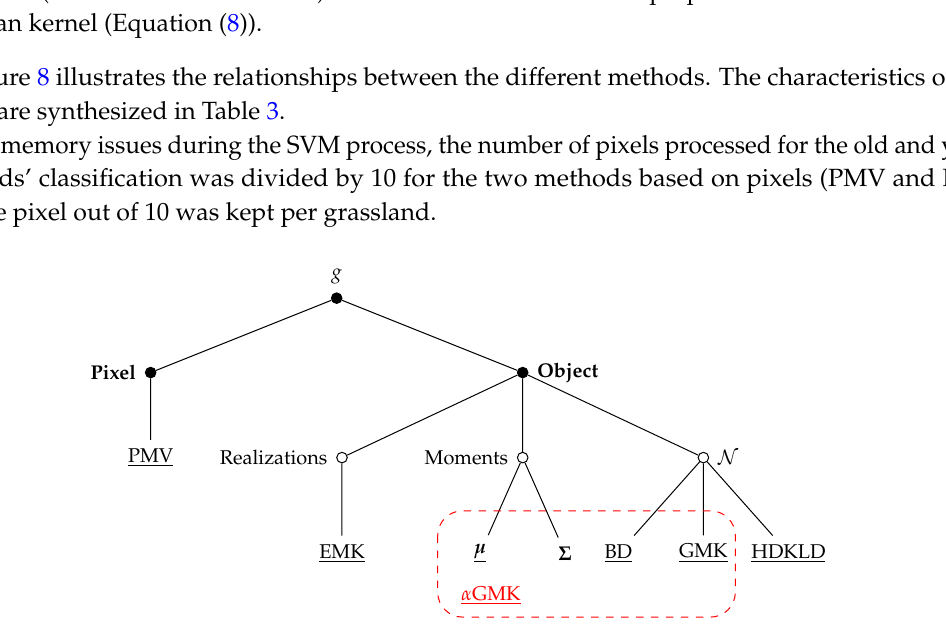
Figure 8. Contribution of the proposed method in grassland analysis for supervised classification.